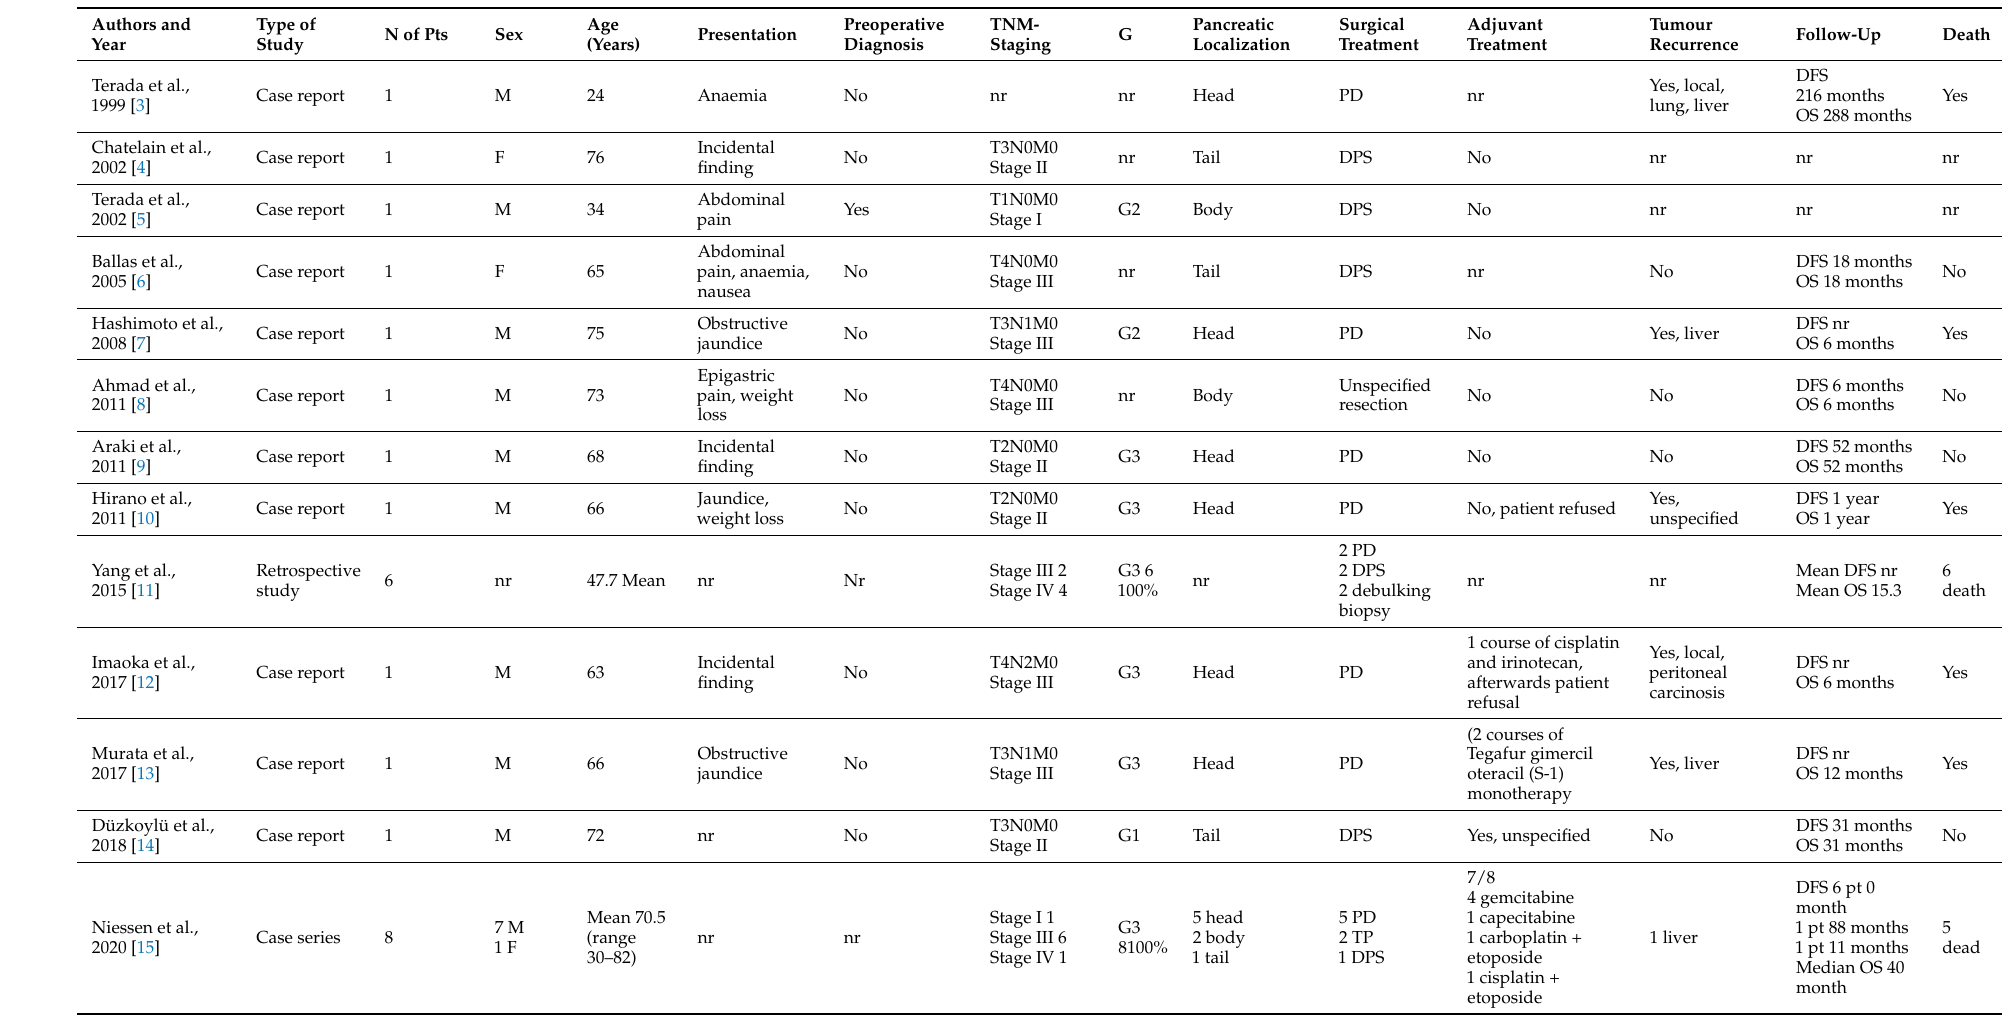
Table 1. Literature review of pancreatic